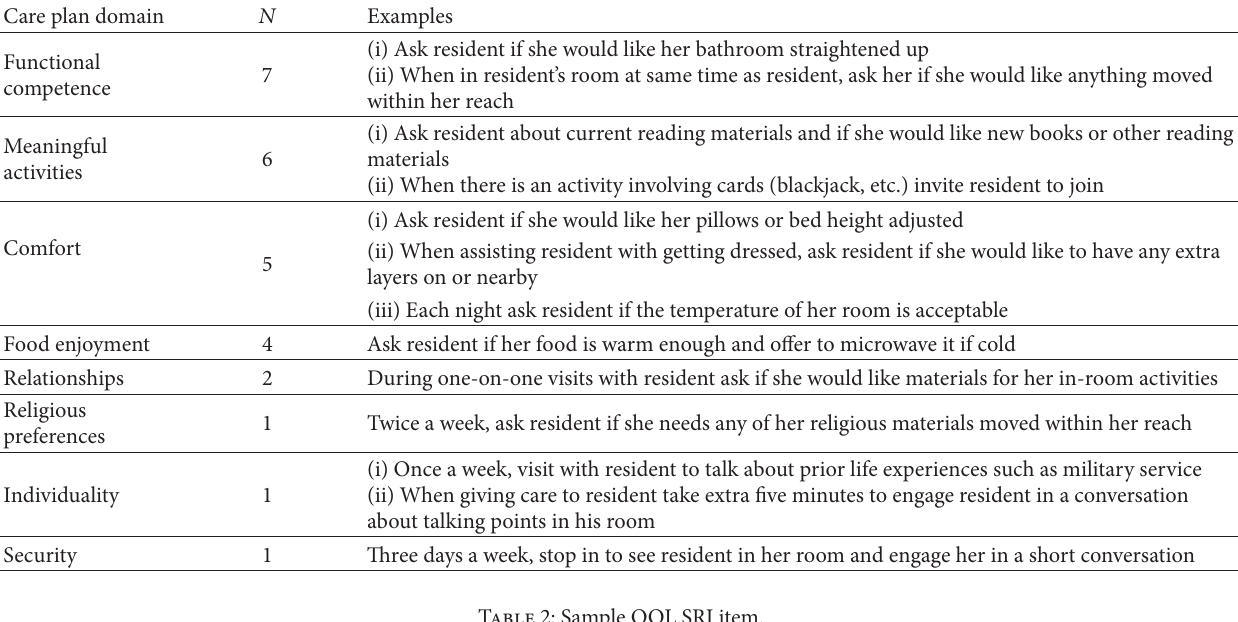
Table 1: Description of sample.